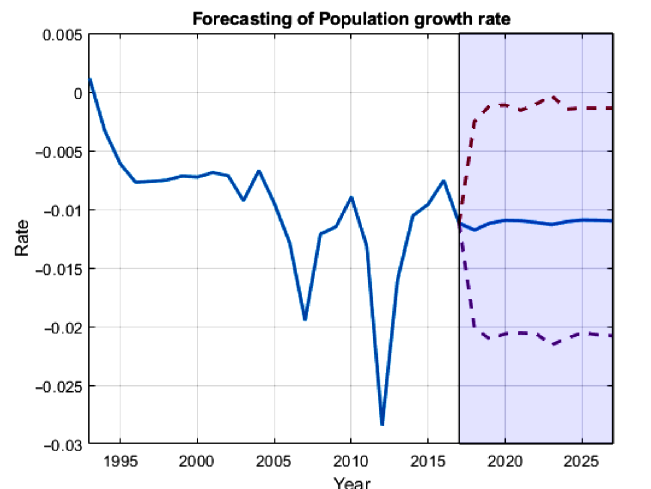
Figure 4. History and forecasting of the population median age (source: authors’